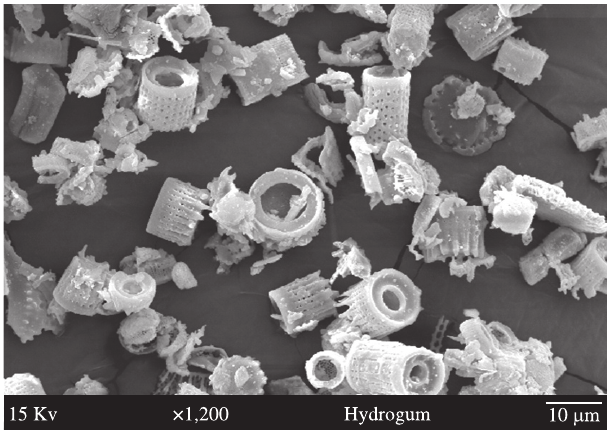
Figure 5. Typical scanning electron photomicrograph of Hydrogum inorganic fraction. Particles can be seen with several shapes and sizes, predominating cylindrical and perforated sticks.